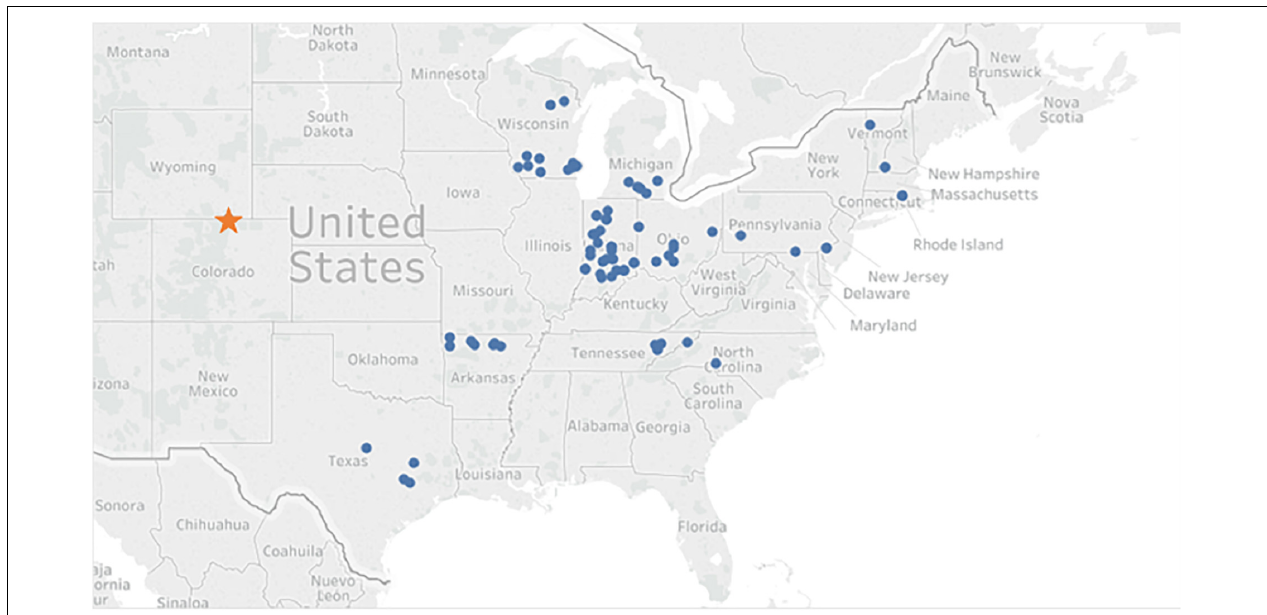
FIGURE 1 | Map of Juglans nigra nut collection locations. Circles represent the location of a parent tree, or the origin of a family and the star indicates the common garden